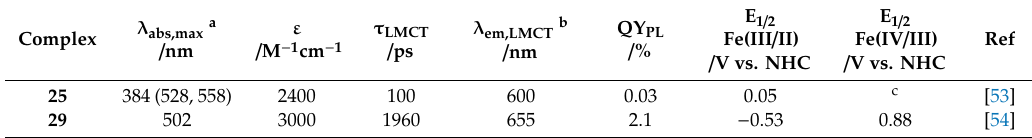
Table 3. Photo(electro)chemical properties of Fe(III)NHC complexes. All measurements in CH 3 CN unless otherwise noted. Electrochemical measurements conducted in CH 3 CN against Fc +/0 and converted to corresponding standard NHE values using a standard reference electrode conversion constant of +0.630 V [55].